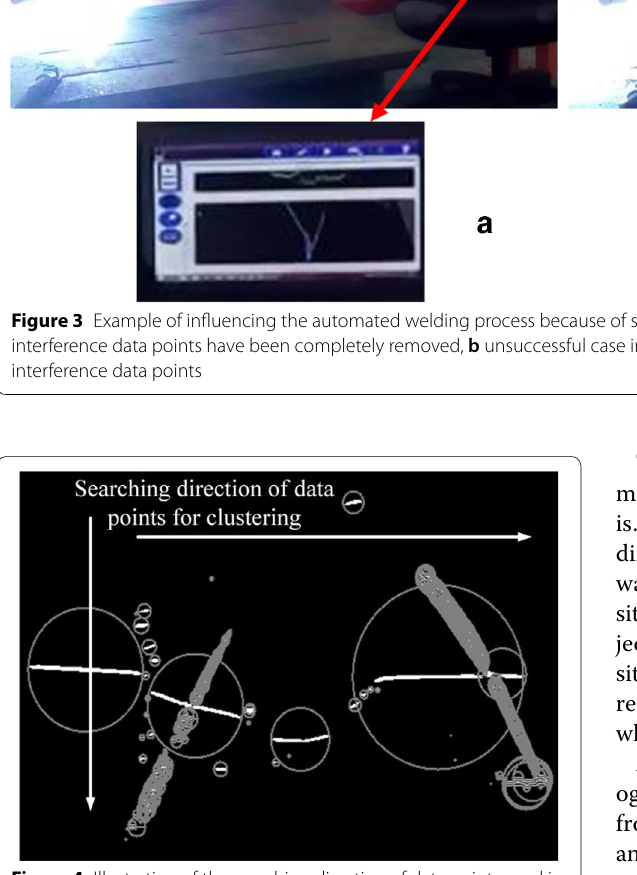
Figure 4 Illustration of the searching direction of data points used in the clustering